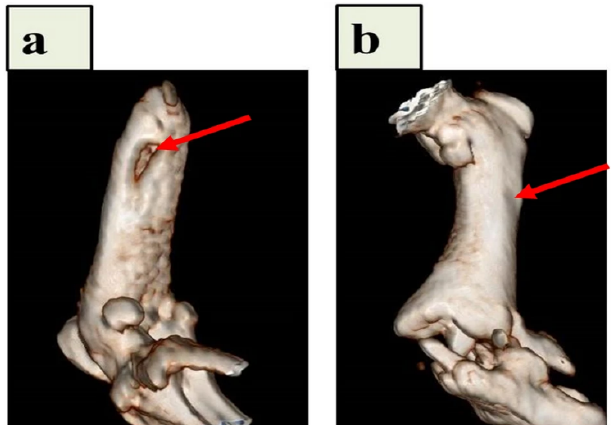
Figure 3. CT pictures of the implanted CNFs/HA nanocomposite that repaired the damaged femur in vivo. After 8 weeks following the accident, diagnostic 3D imaging (CT scan) was conducted of the femur bone defects. The arrow indicates the deficient area that was not healed in the control group ( a ) and the bone defect that was corrected as a result of the implanted CNFs/HA nanocomposite stimulating the growth of normal tissue ( b ). Reproduced with permission from Ref.